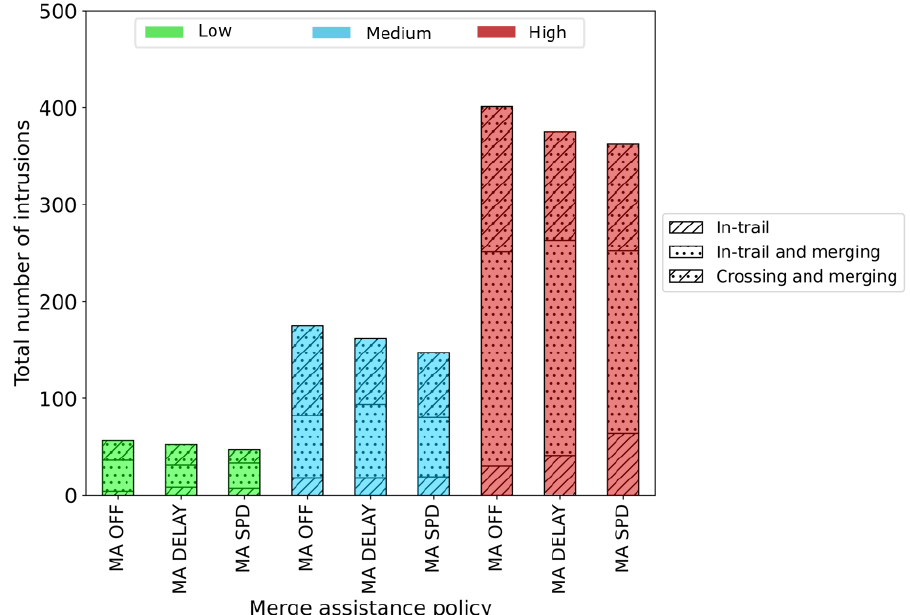
Figure 7. The total number of pairwise intrusions and their associated type with and without merge assistance for low, medium and high traffic demand. Note that MA OFF means without merge assistance. All three cases (MA OFF, MA Delay and MA SPD) also consider the effect of the tactical conflict resolution.